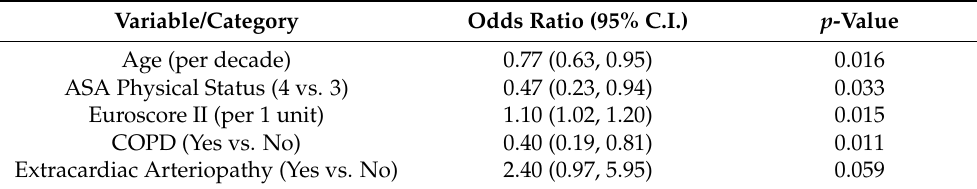
Table 3. Multivariable Logistic Regression Model Estimates for Volatile Exposure (ET ISO ≥ 0.5 MAC , 30 min ) during the Post-Bypass Period.